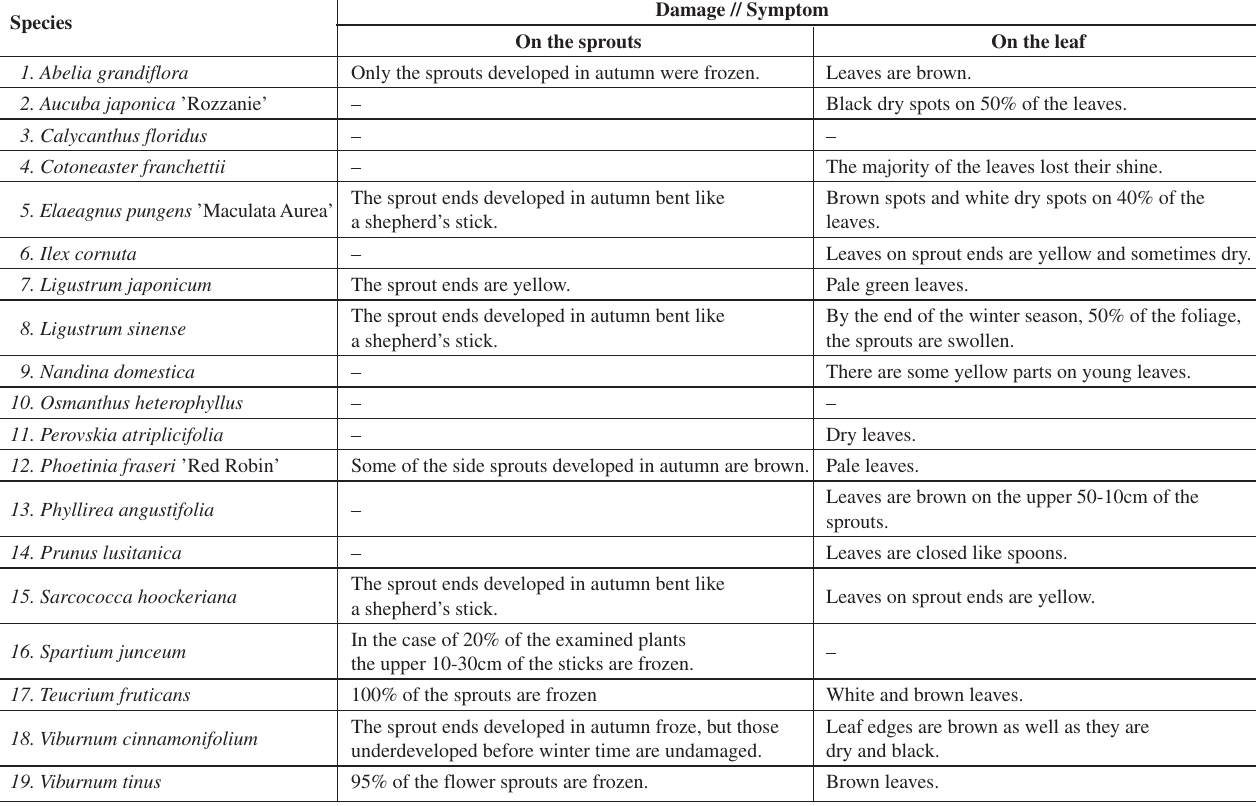
Table 2: Visible effects of winter damage on the examined species